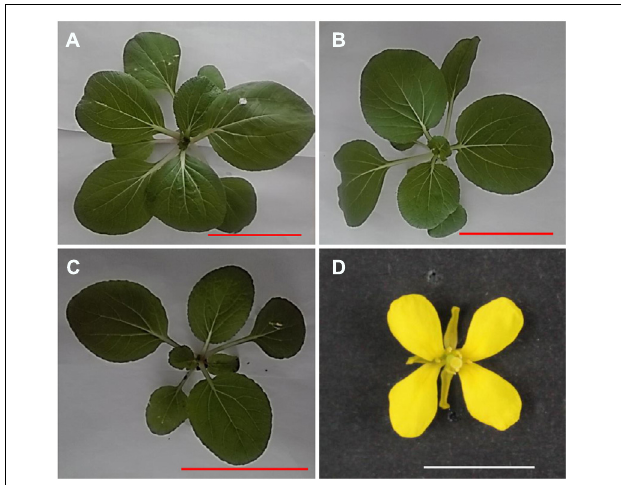
FIGURE 1 | Morphology of aneuploidy RBR Oro, MAAL C1 and Cs1 at seedling stage and flower of Cs1. (A–C) Young seedlings for RBR Oro, MAAL C1 and Cs1, bar: 5 cm. (D) The Cs1 plant shows abnormal flower with defective stamen, bar: 1 cm.